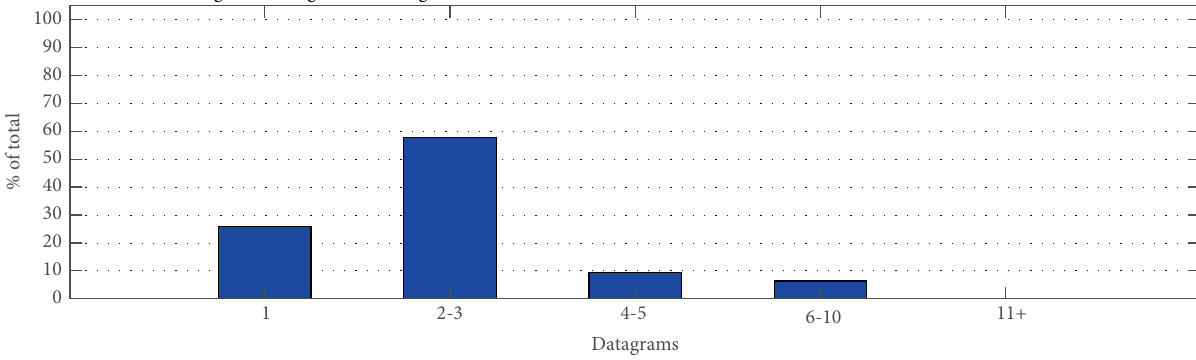
Figure 9: Consecutive lost datagrams histogram of timing records.